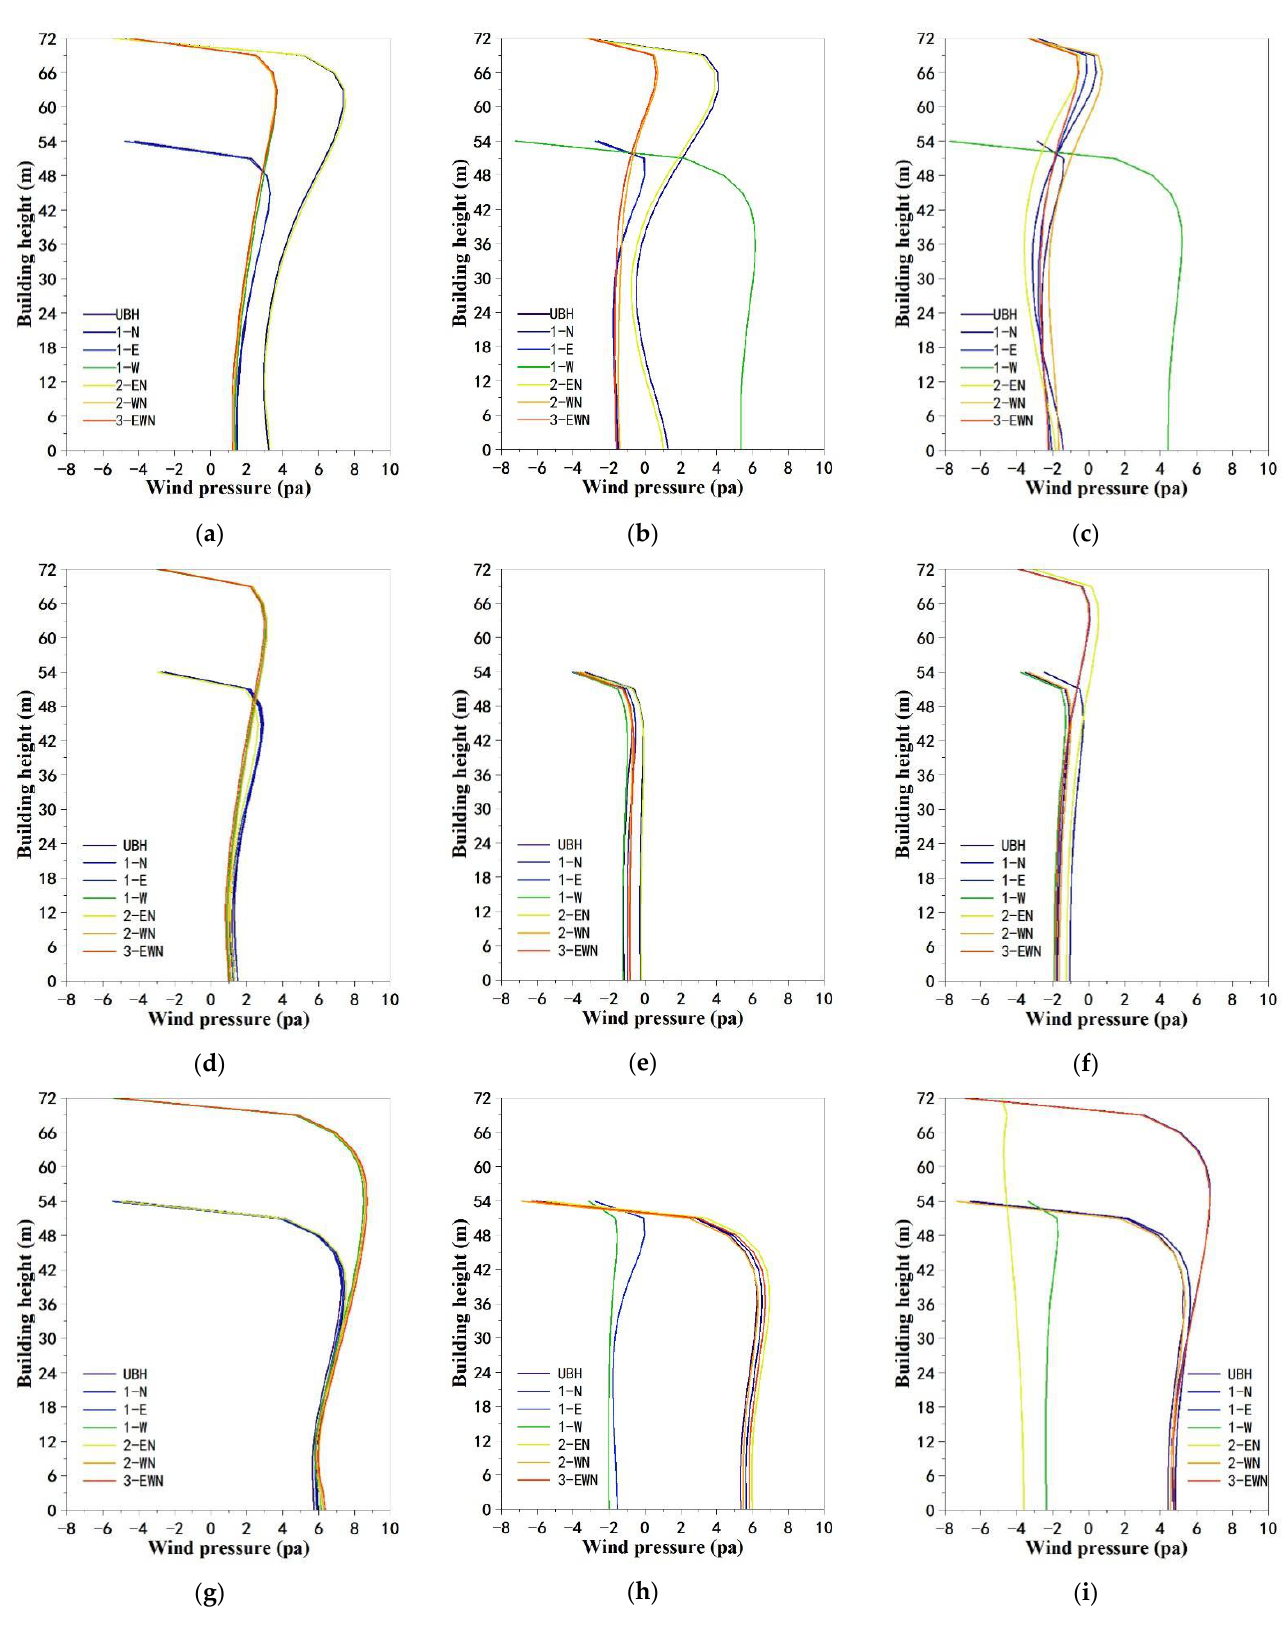
Figure A9. Wind pressure on the windward side of single buildings under seven operating condi- tions; ( a ) building #1, ( b ) building #2, ( c ) building #3, ( d ) building #4, ( e ) building #5, ( f ) building #6,